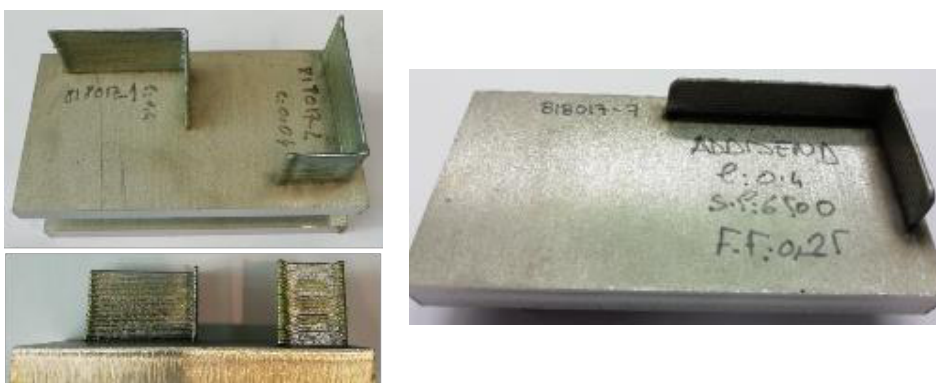
Figure 4. Thin walls manufactured by LMD-powder. 20 × 40 × 25 mm wall made of SS316L without process control and different “e” parameters ( left ) and 30 × 50 × 10 mm wall made of IN718 with process control ( right ).